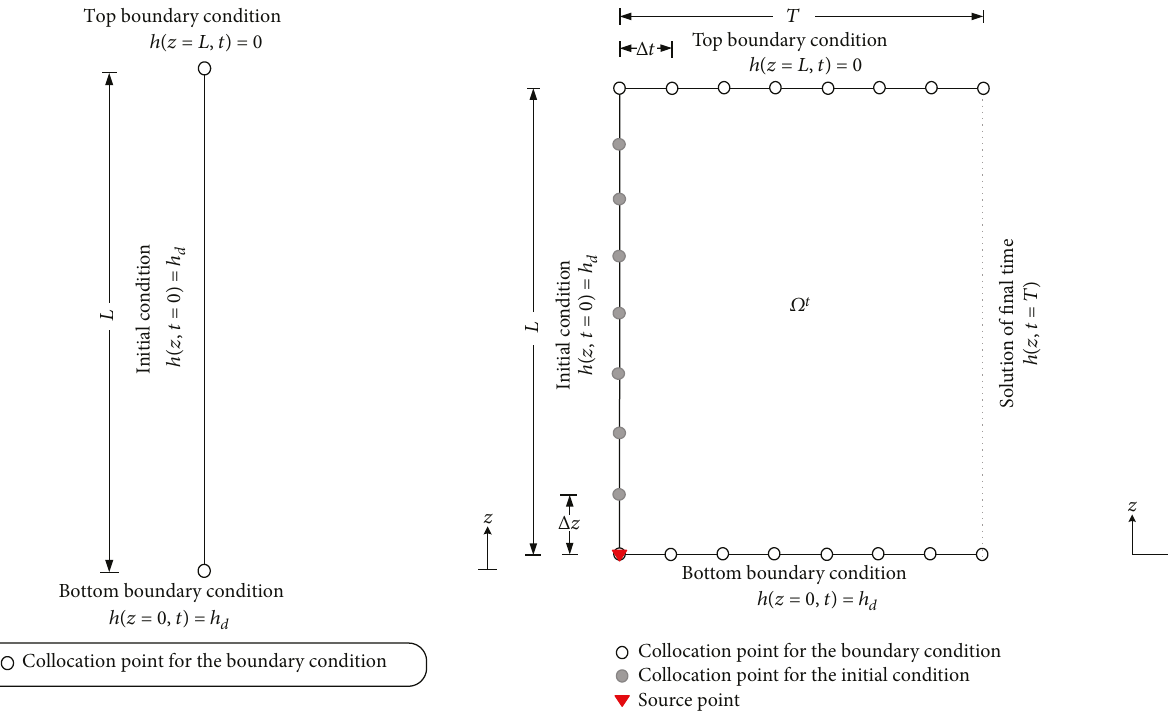
Figure 2: Illustration of the proposed collocation